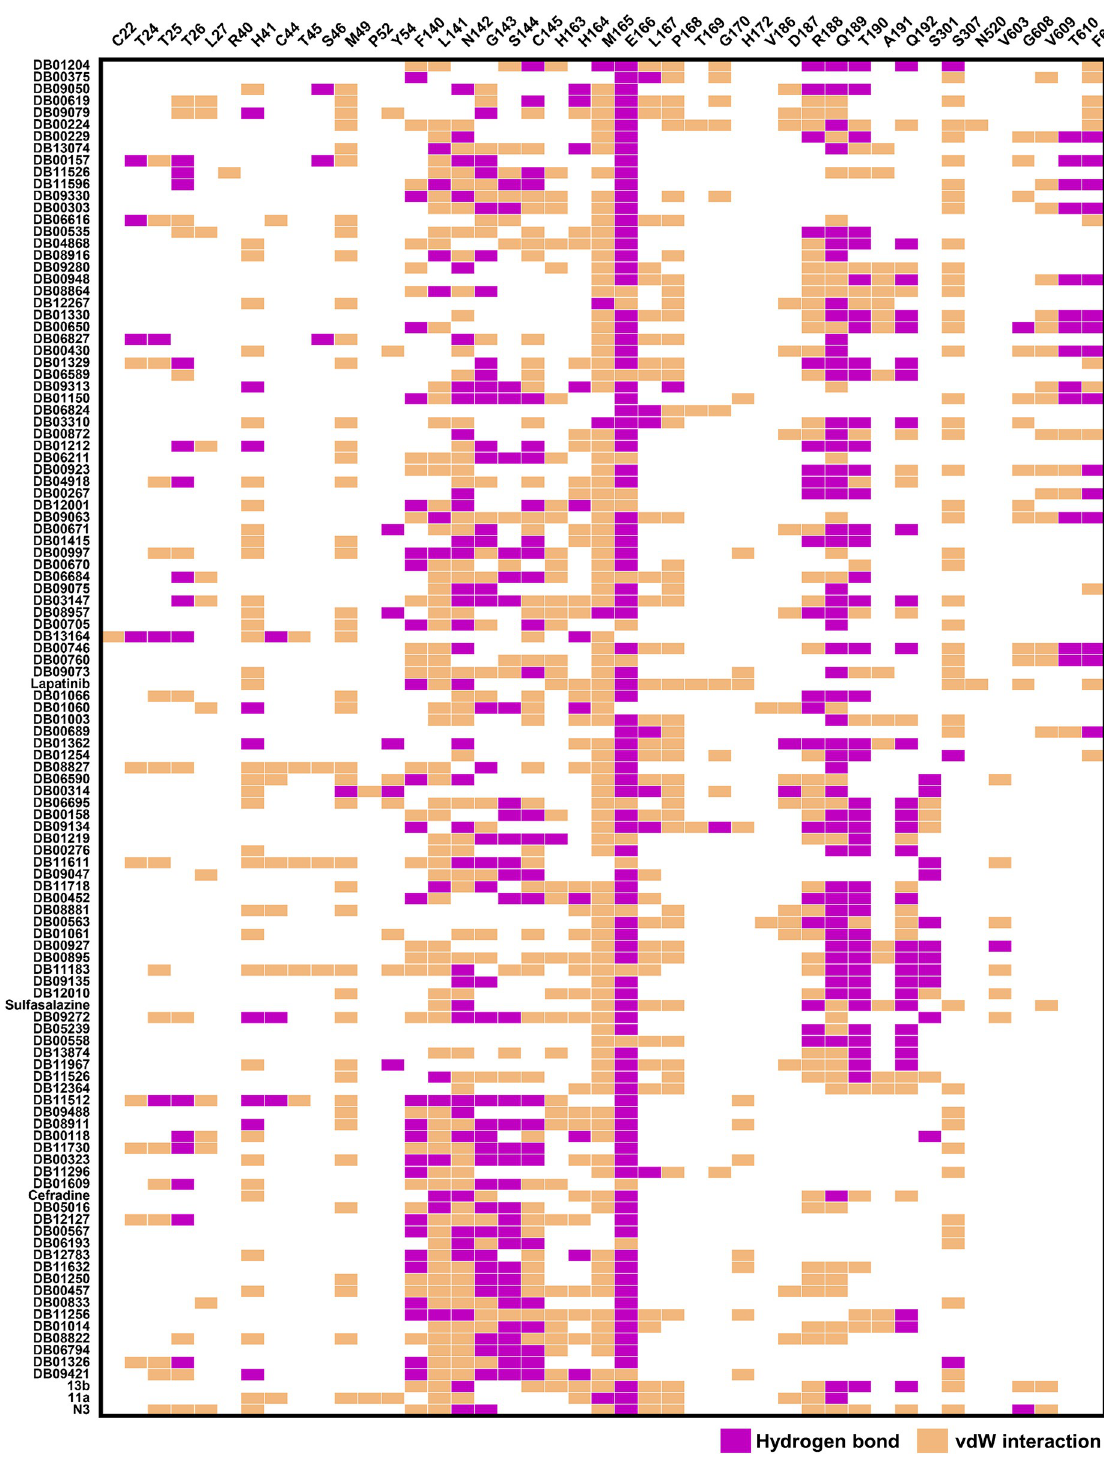
Fig 4. Heat map of the top compounds interacting with SARS-CoV-2 3CL pro derived from Fig 3 relative to the known inhibitors derived from LigPlot version 2.2.